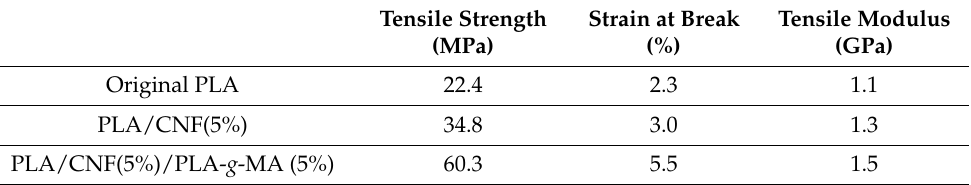
Table 2. Mechanical properties of PLA, PLA/CNF and PLA/CNF/PLA- g -MA (extract of data from Ghasemi et al. [24]).